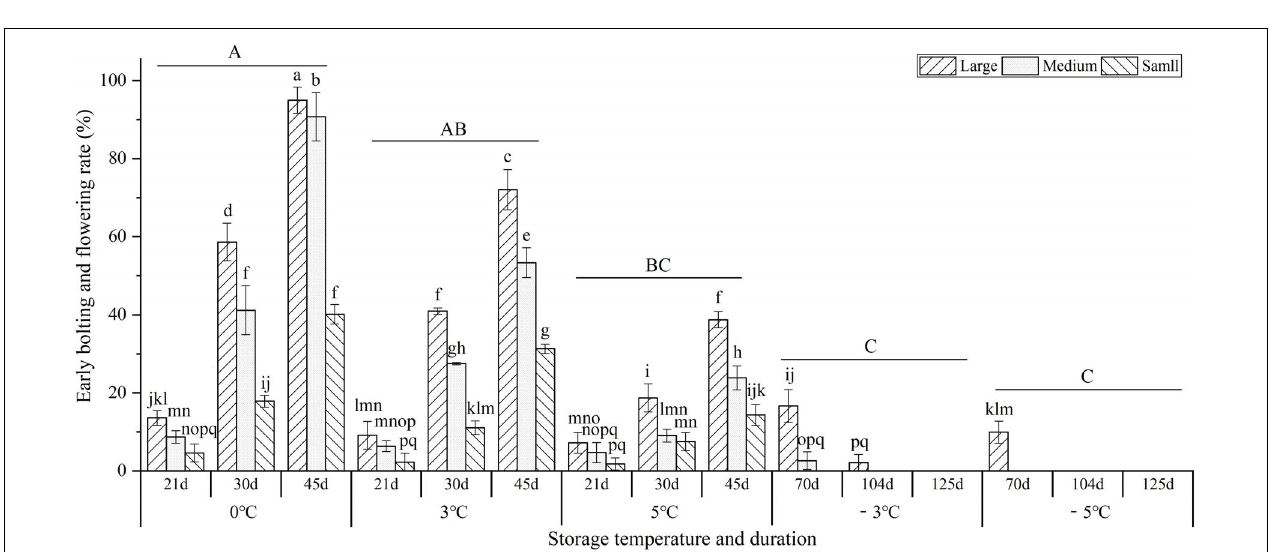
FIGURE 3 | Changes in the early bolting and flowering (EBF) rates of seedlings at different storage temperatures and durations. Different uppercase letters represent a significant difference ( P < 0.05) in the average value of different seedlings and storage durations among different temperatures. Different lowercase letters represent a significant difference between the size treatments and storage durations among different temperatures.